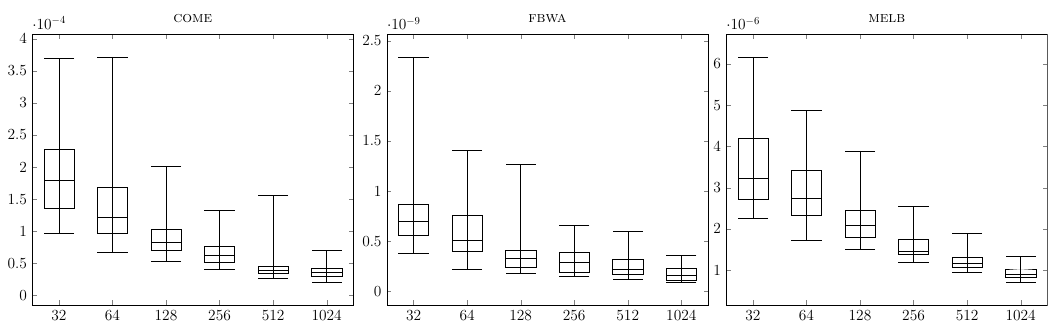
Figure 4. The mean absolute error of APX - h as a function of h , in the case of the temporal graphs COME , FBWA , and MELB . For each graph and for each sample size h , the corresponding box-and-whisker plot depicts the Mean Absolute Error (MAE) through its